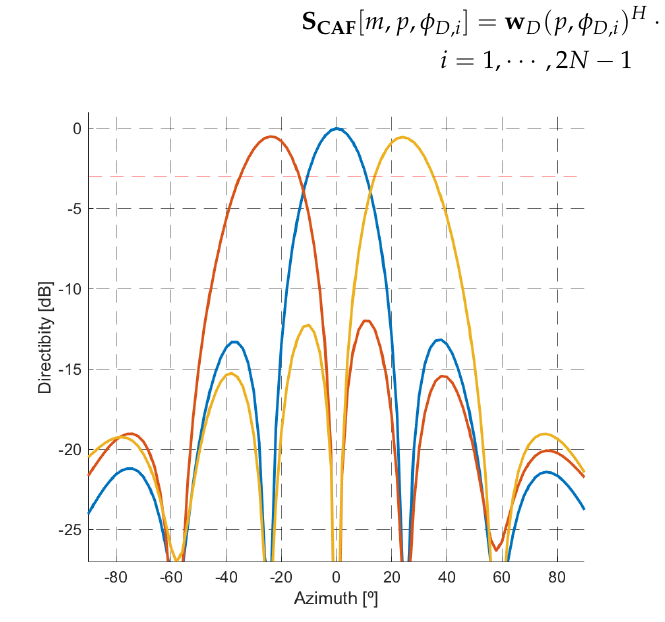
Figure 4. Set of three orthogonal beams for a five elements